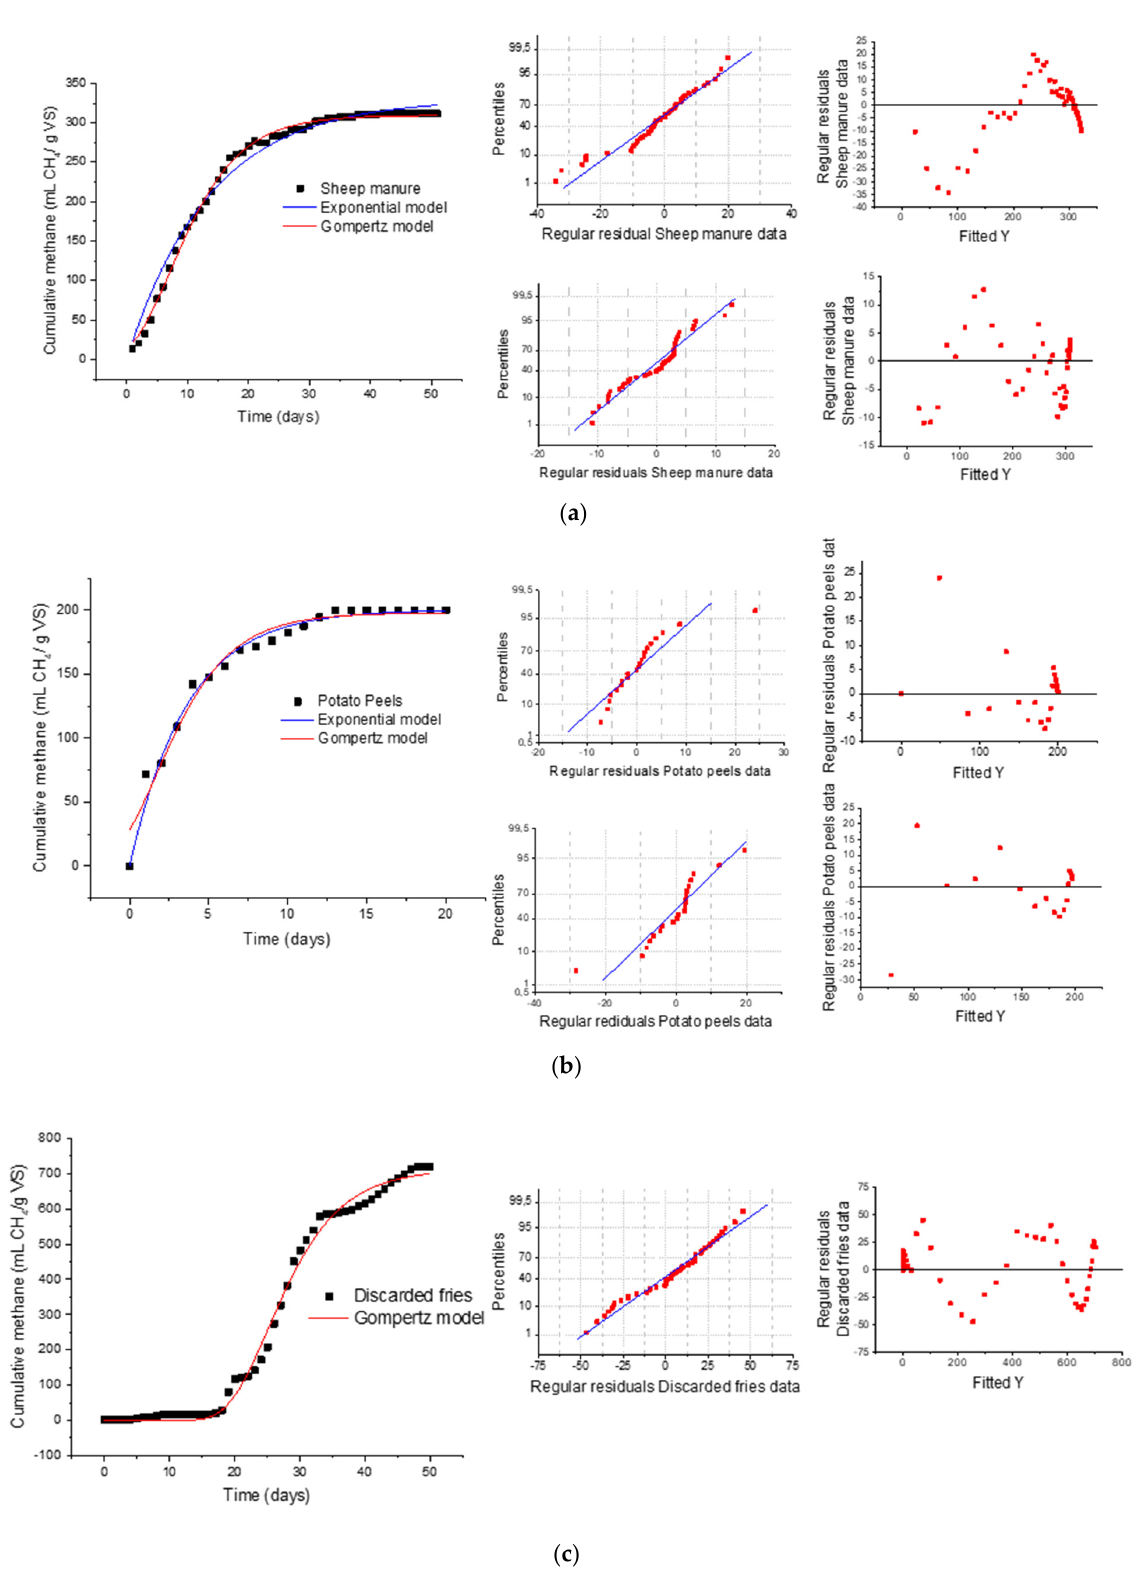
Figure 3. Results obtained from adjusting exponential and modified Gompertz models to cumulative curves for methane. Data obtained from batch digestion of samples of ( a ) sheep manure, ( b ) potato peels, and ( c ) discarded chips.